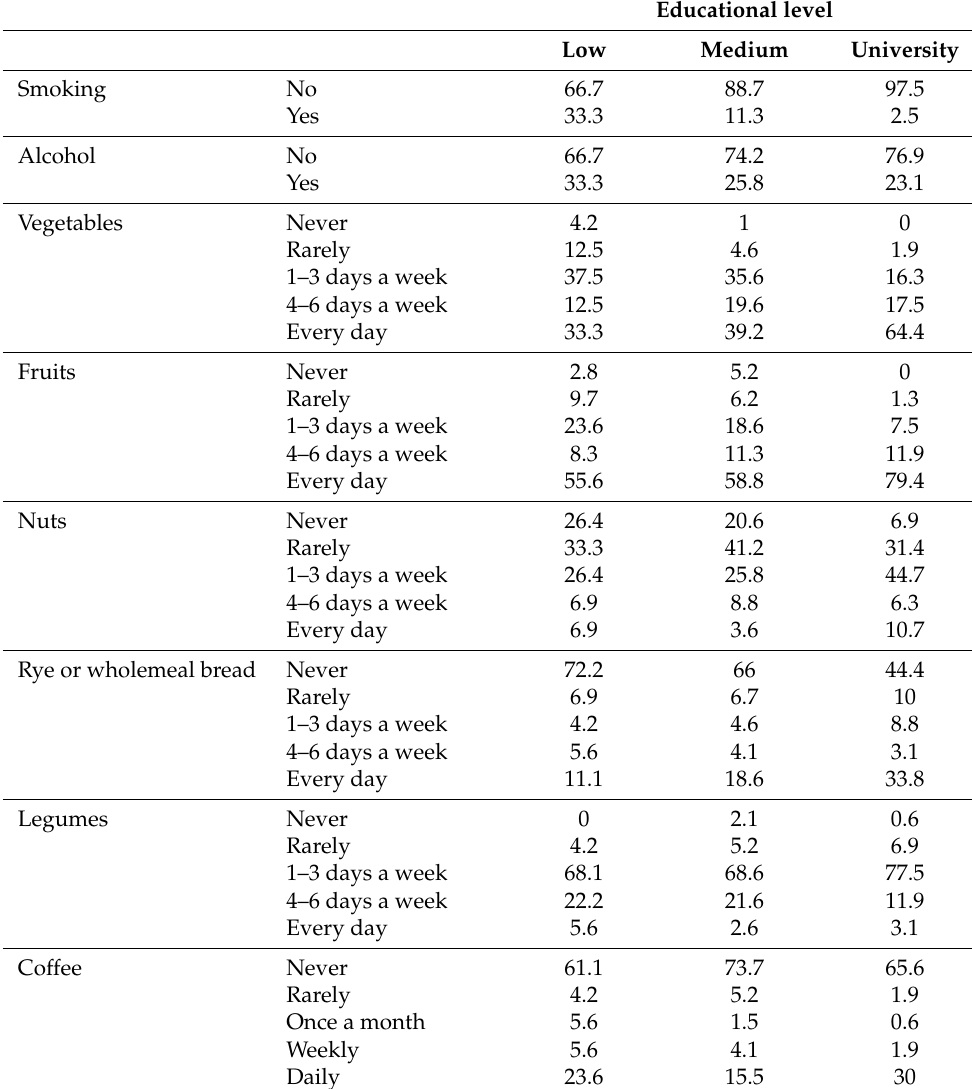
Table 4. Percentage distribution of study variables by educational